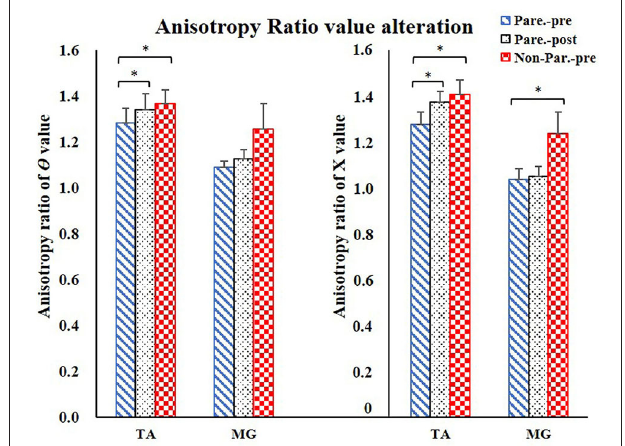
FIGURE 4 | Anisotropy Ratio parameter comparison. For comparison between paretic and non-paretic muscles, significantly lower AR of θ value was shown in TA, significantly lower AR of X value was shown in TA and MG. After training, only TA presented significant increase on the AR of θ and AR of X values. AR, anisotropy ratio; X, reactance; θ , phase angle; TA, tibialis anterior; MG, Medial head of gastrocnemius. * P <